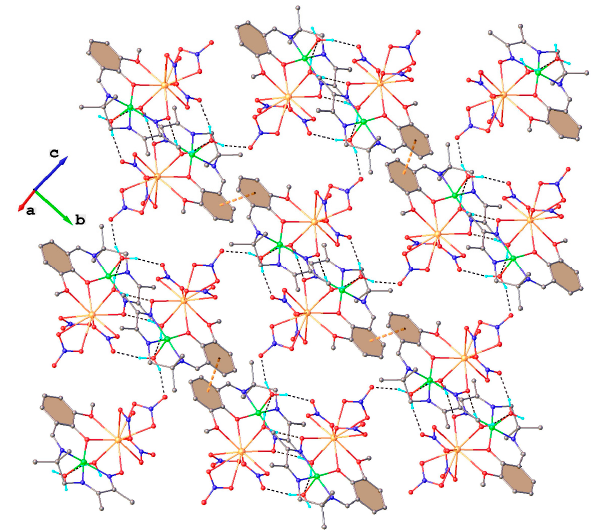
Figure 9. View of the 2D supramolecular layer in 8 along a axis. H-bonds and centroid-to-centroid distances (3.869(5) Å) are shown in black and orange dashed lines, respectively. H-bond parameters: